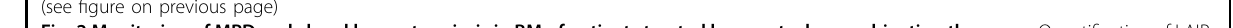
Fig. 2 Monitoring of MRD and clonal haematopoiesis in BM of patients treated by venetoclax combination therapy. a Quanti fi cation of LAIP- MRD at fi rst BM assessment after the beginning of treatment (after C1 ( n = 9), after C2 ( n = 2) or after C3 ( n = 1)). Red points indicate patients who did not achieved CR/CRi. The Gray zone on the graph indicates the limit of quanti fi cation (0.1%). b Quanti fi cation of LSCs-MRD at fi rst BM assessment after the beginning of treatment (after C1 ( n = 10), after C2 ( n = 3) or after C3 ( n = 1)). Red points indicate patients who did not achieved CR/CRi. The Gray zone on the graph indicates the limit of quanti fi cation (0.01%). Follow up of MRD by MFC for patients who achieved CR/Cri without (group 1; n = 6) ( c ) or with relapse at any time during the study (group 2; n = 7) ( d ). A positive MRD was attested if either or both LAIP-MRD and/or a LSCs-MRD were detected above the limit of quanti fi cation. e Median response duration for all patients who achieved CR/CRi according their MRD status (either LAIP-MRD and/or LSCs-MRD) during the follow-up under treatment (always negative or at least one time positive). Follow-up of VAF mutations detected by HTS at different time points during therapy for patients who achieved CR/Cri without (group 1; n = 7) ( f ) or with relapse at any time during the study (group 2; n = 9) ( g ). Gray bars indicate mutations whose VAF only slightly decreased or increased during follow-up. Red bars indicates mutations whose VAF increased under therapy. Blue bars indicates mutations whose VAF strongly (at least 70% of decrease) decreased during